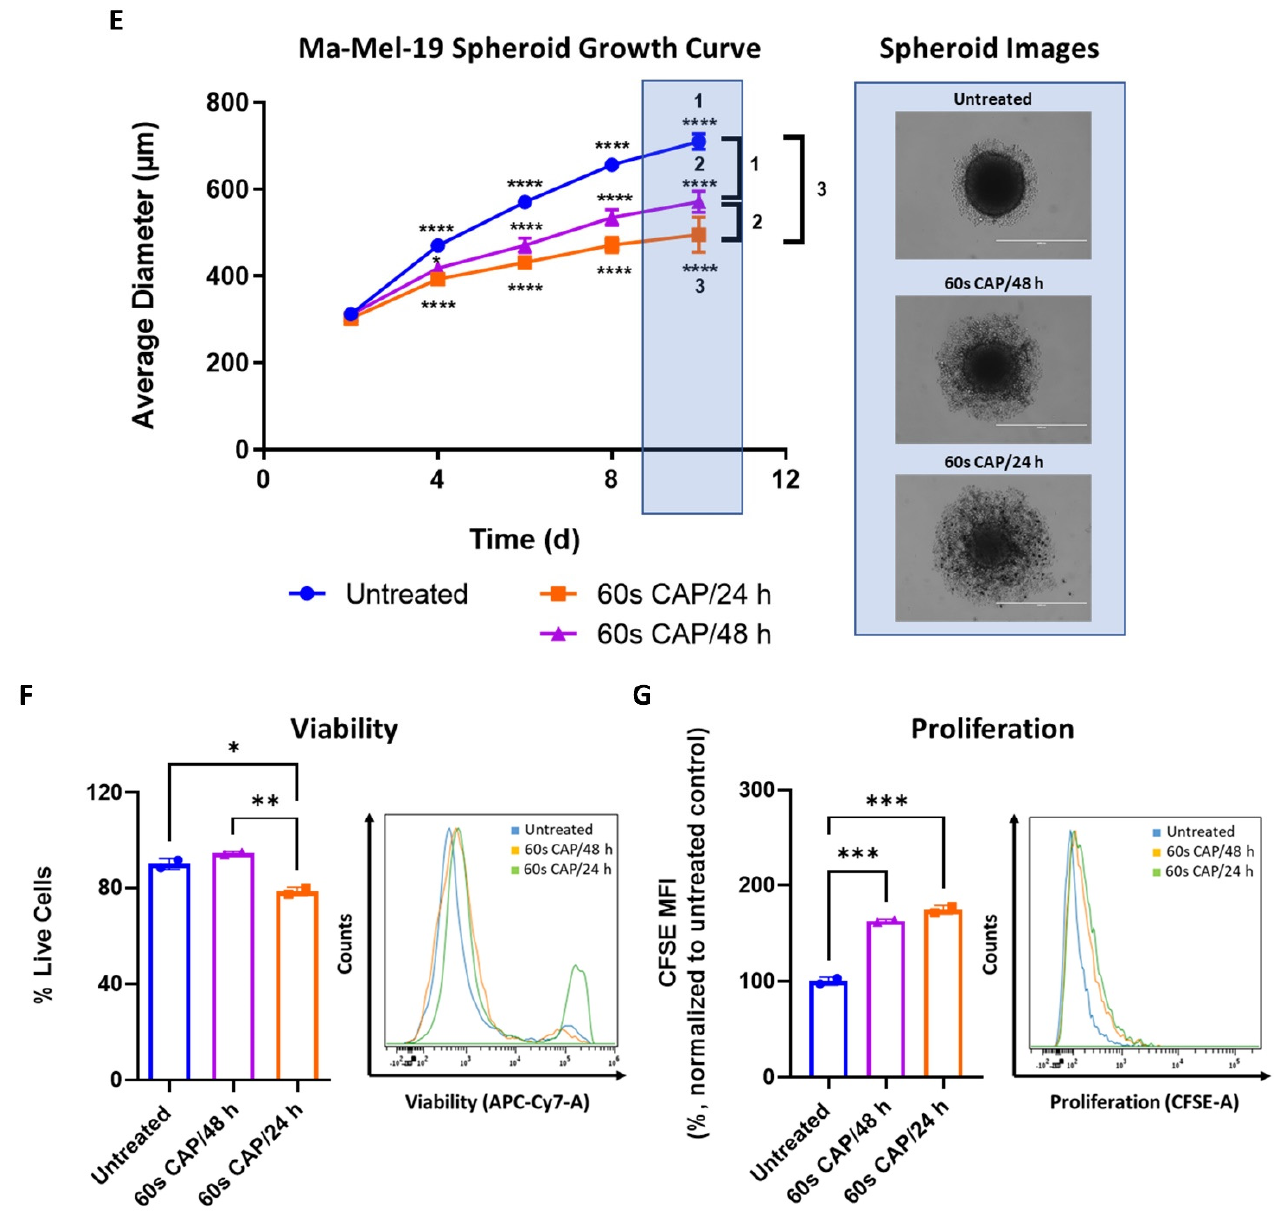
Figure 7. Ma-Mel-19 cells are more resistant to repeated CAP treatment when grown as 3D tumor spheroids. ( A , B ) CFSE prelabeled Ma-Mel-19 cells were grown in 2D in vitro monolayers and treated with 60 s CAP for 3 consecutive days. On the day after, cells were analyzed in flow cytometry; ( A ) cells were stained for viability. Bar diagram shows the average percentage of live cells measured ( n = 3) ± SD; ( B ) bar diagram shows the average CFSE mean fluorescent intensity (MFI) normalized to the untreated control ( n = 3) ± SD; statistical significance was calculated by performing paired Student’s t -tests; ( C , D ) CFSE prelabeled Ma-Mel-19 cells were grown as 3D in vitro tumor spheroids and were treated with 60 s CAP for 3 consecutive days. On the day after, spheroids were pooled ( n = 6 spheroids/replicate of each condition, n = 3), digested, and analyzed in flow cytometry; ( C ) spheroids were stained for viability. Bar diagram shows the average percentage of live cells measured ± SD; ( D ) bar diagram shows the average CFSE MFI measured, normalized to the untreated control ± SD; statistical significance was calculated by performing paired Student’s t -tests; ( E – G ) CFSE prelabeled Ma-Mel-19 cells were grown as 3D in vitro tumor spheroids. Spheroids were treated with 60 s of CAP every day (60 s CAP/24 h) or every other day (60 s CAP/48 h) for 8 consecutive days. On the day after, spheroids were pooled ( n = 6 spheroids/replicate of each condition, n = 2), digested, and